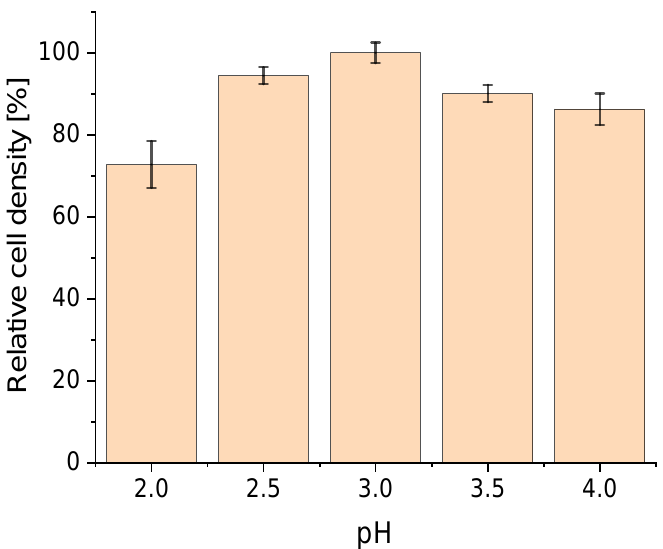
Figure 1. Relative cell density [%] of Sulfolobus acidocaldarius in response to different pH values (2.0 – 4.0) in a chemostat cultivation at 75 °C and a set dilution rate of 0.03 h −1 . Error bars indicate the standard deviation of cell density between sampling points after reaching steady state.